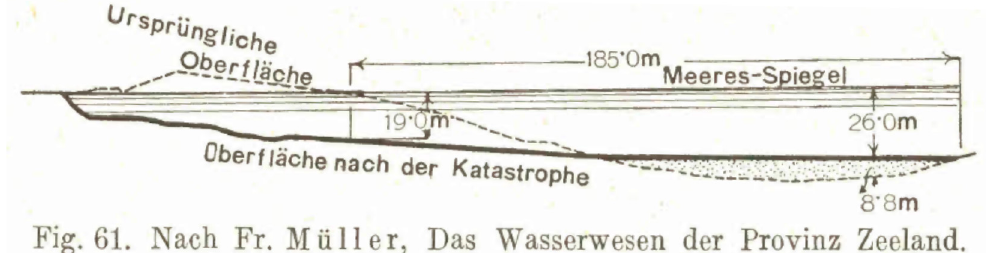
Figure 5. Cross section of a flow slide from Terzaghi, F. Deuticke Verlag, Leipzig, 1925 [15]; later published in English [17], referring to Fr. Müller, [14].